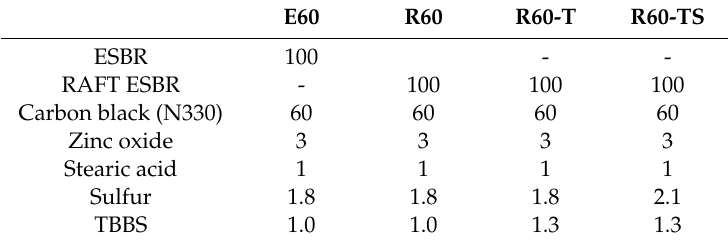
Table 3. Formulation of carbon black-filled compounds for increasing crosslink density; (Unit: phr).